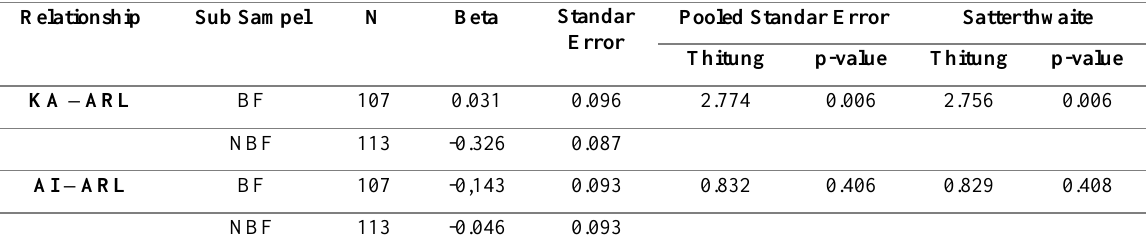
Table 2: Hypothesis Test